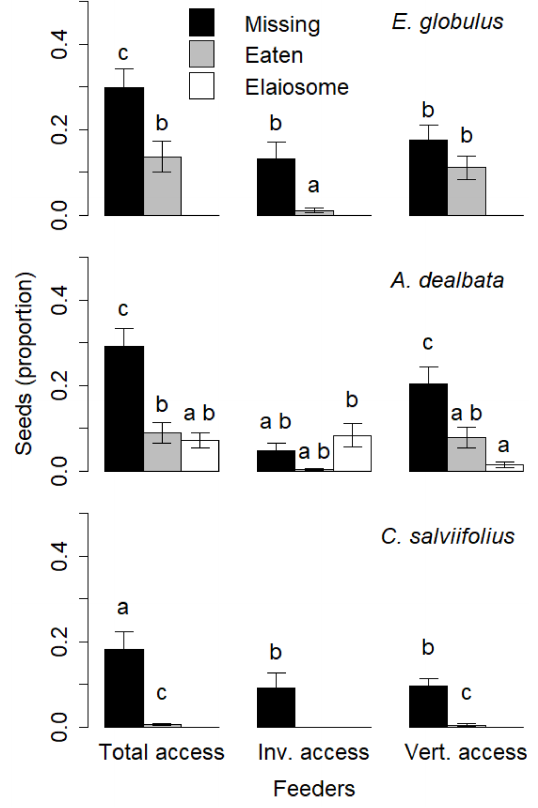
Figure 5. Proportion of seeds used according to the seed species, feeder type and the type of action on the seed (missing, eaten, elaio- some detached). Different letters above the bars indicate significant differences (post hoc pairwise Tukey tests).